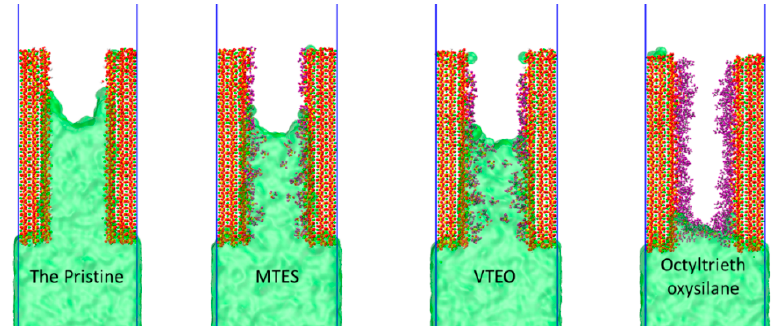
Figure 11. Screenshots of the four models of water molecules at 800 ps.